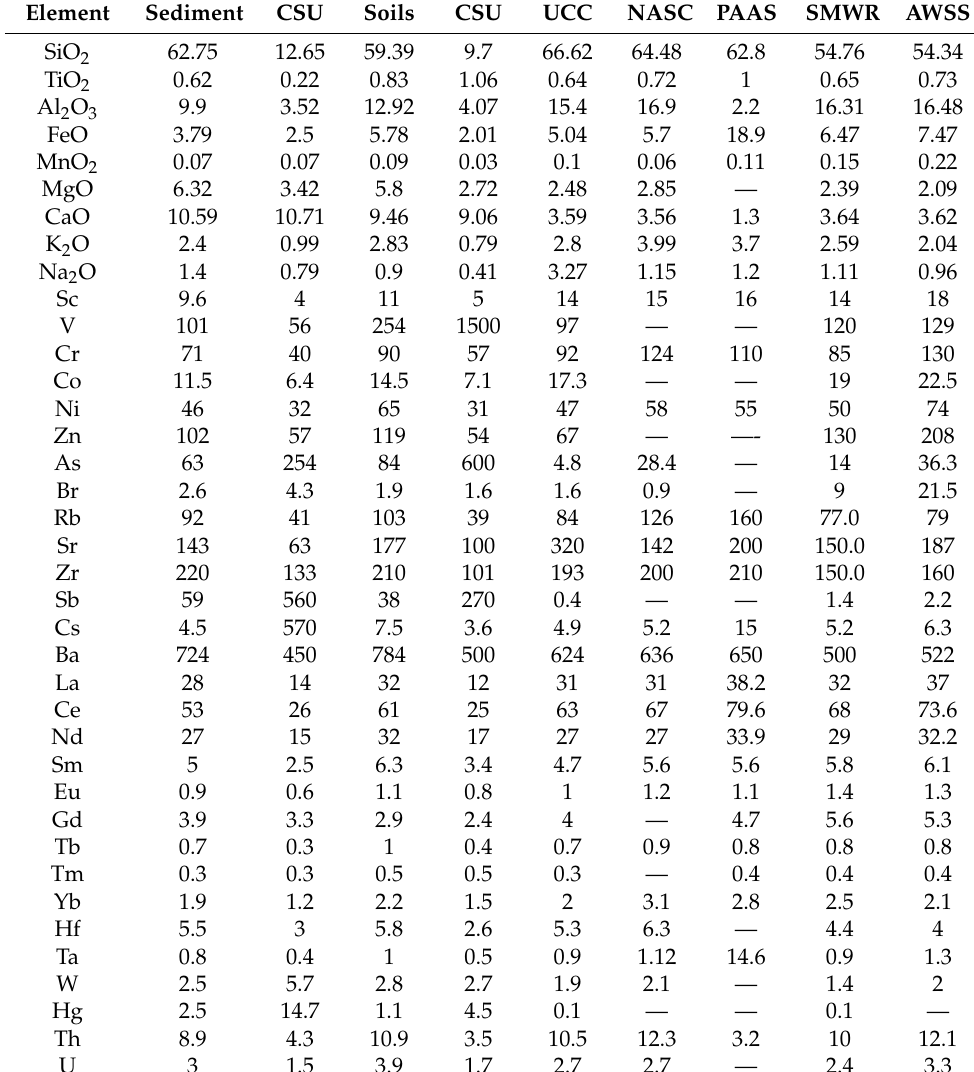
Table 1. The mass fraction of investigated elements in sediments and soils as well as the main literature references: UCC [17]; North American Shale Composite NASC [18]; Post Archaean Aus- tralian Shale (PAAS) [8]; Suspended Matter of the World’s Rivers (SMWR) [19]; as well as Average World Suspended Sediments (AWSS) [20]. Oxides’ mass fraction expressed in wt.%, in mg/kg for other elements, excepting Hg of which the mass fraction is expressed in µ g/kg. CSU represents the Combined Standard Uncertainty [21]. Element